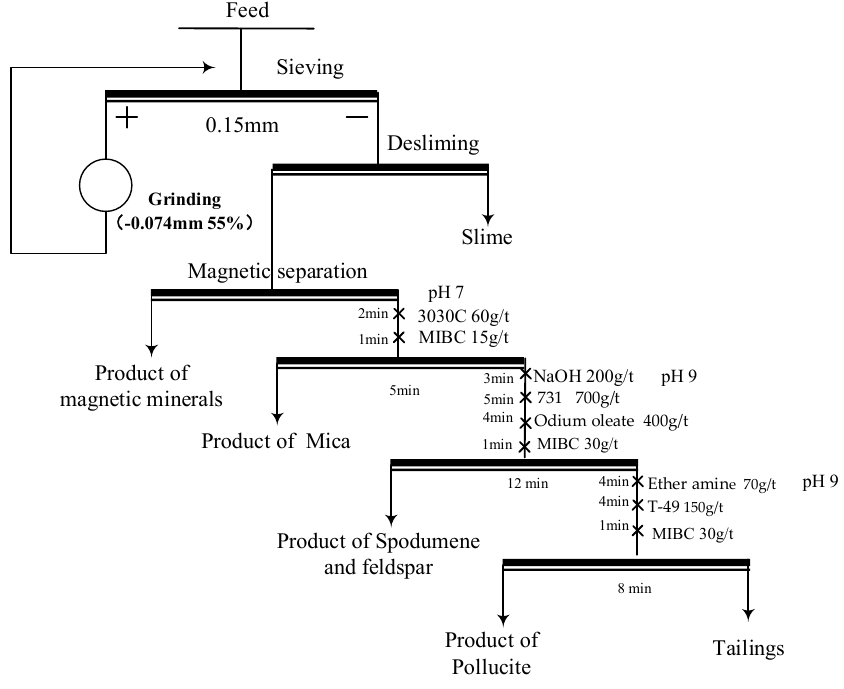
Figure 8. Beneficiation flowsheet for pollucite. Table 8. Pollucite beneficiation results.